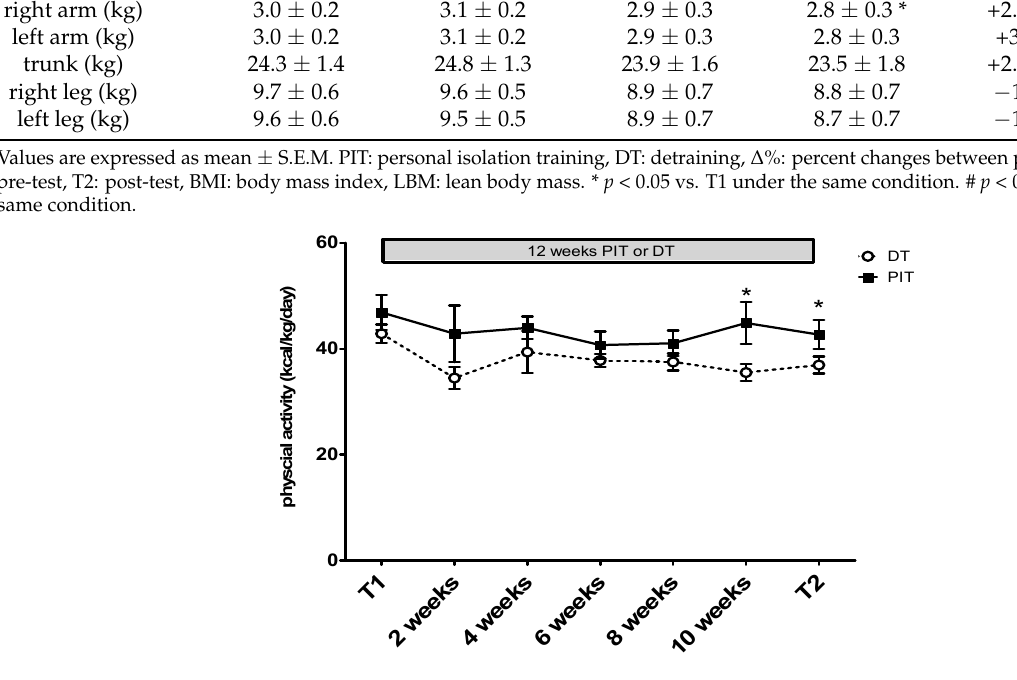
Figure 7. Physical activity volume results. * p < 0.05 vs. DT at the same time-point.